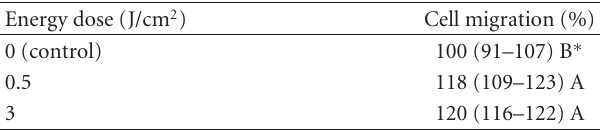
Table 3: Cell migration (%) by the transwell assay, according to the energy dose used in the low-level laser